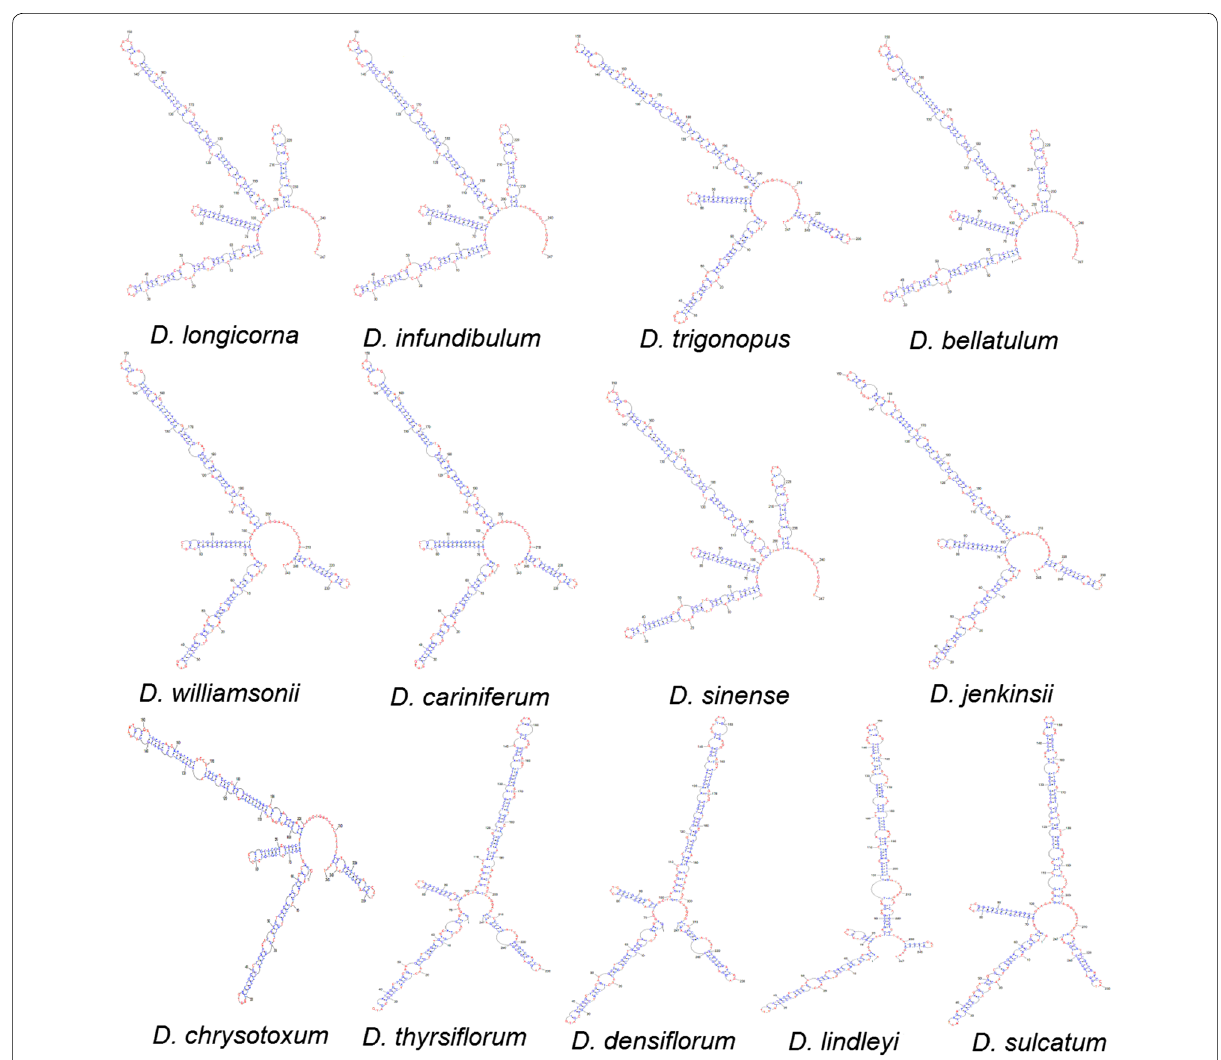
Fig. 3 Diagram of secondary structure of ITS2 transcript of Dendrobium